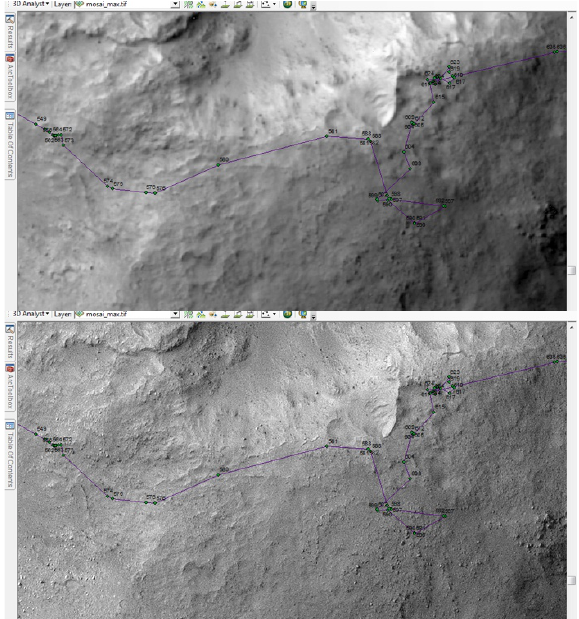
Figure 2 An example of MER-A 25cm HiRISE image (top) and 5cm SRR image (bottom) over the rover traverse on Sol 549-636.